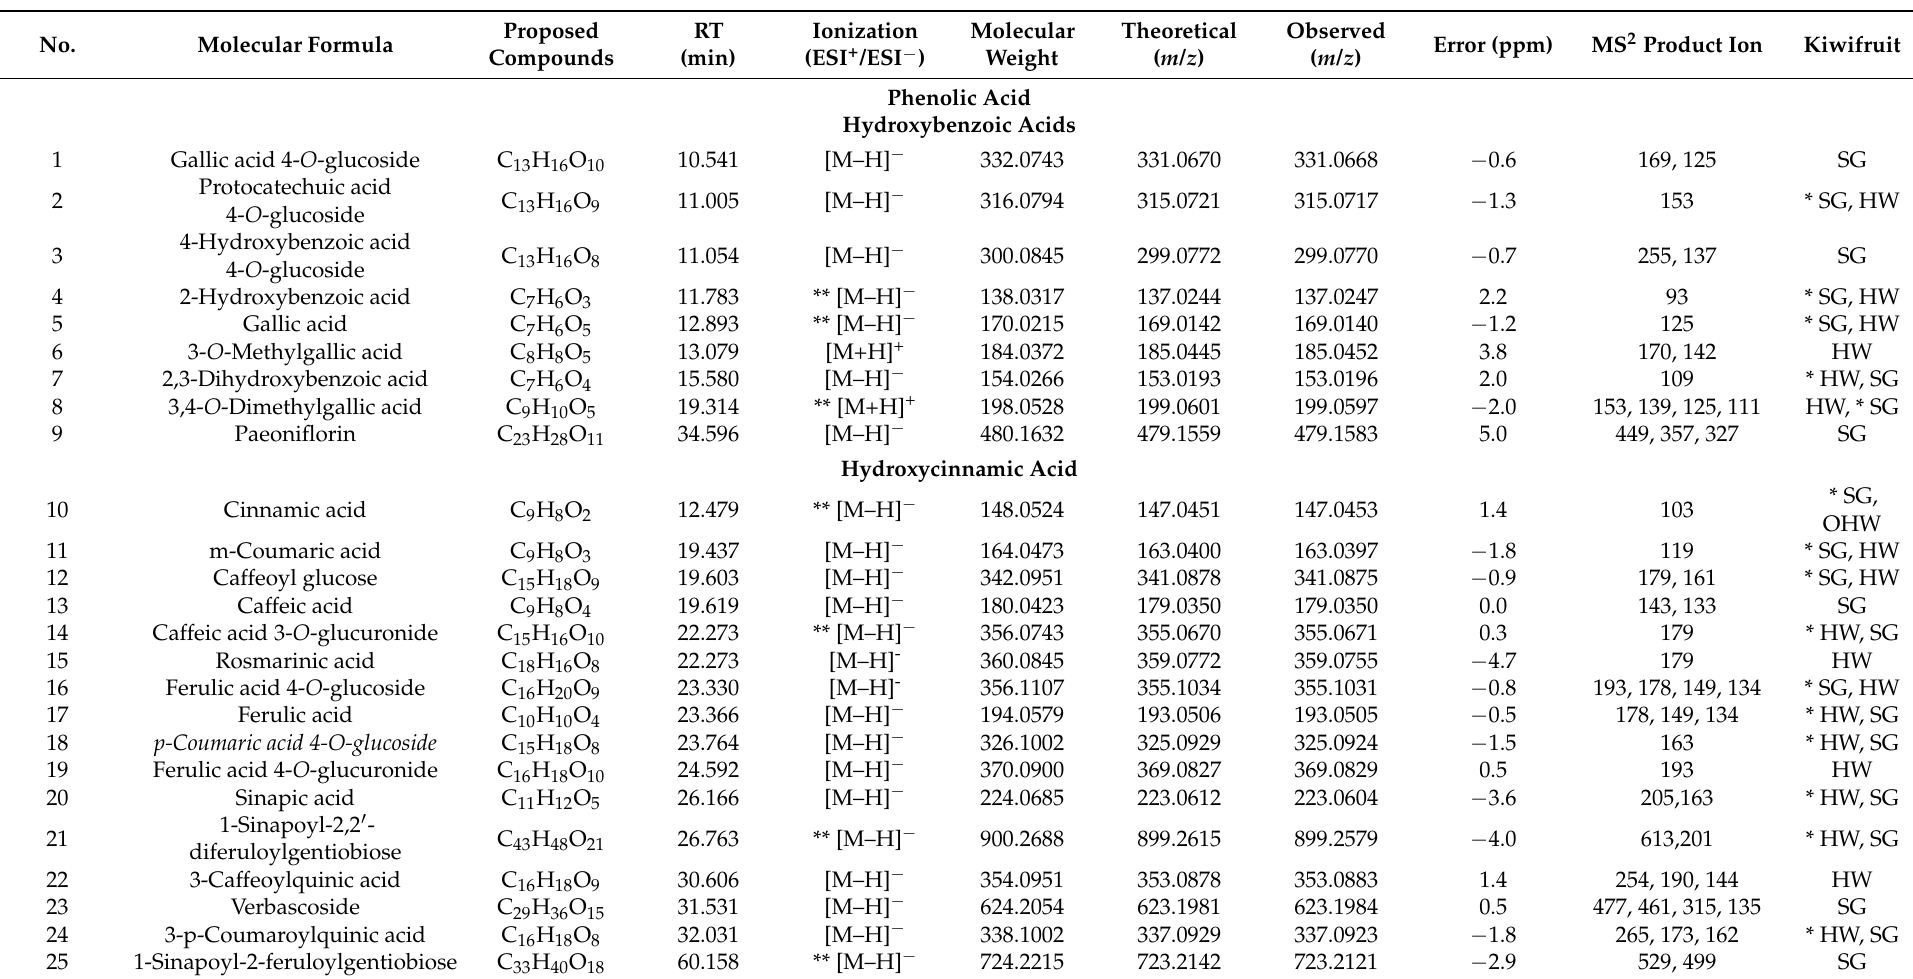
Table 2. LC-ESI-QTOF-MS/MS characterization of phenolic compounds in different kiwifruit